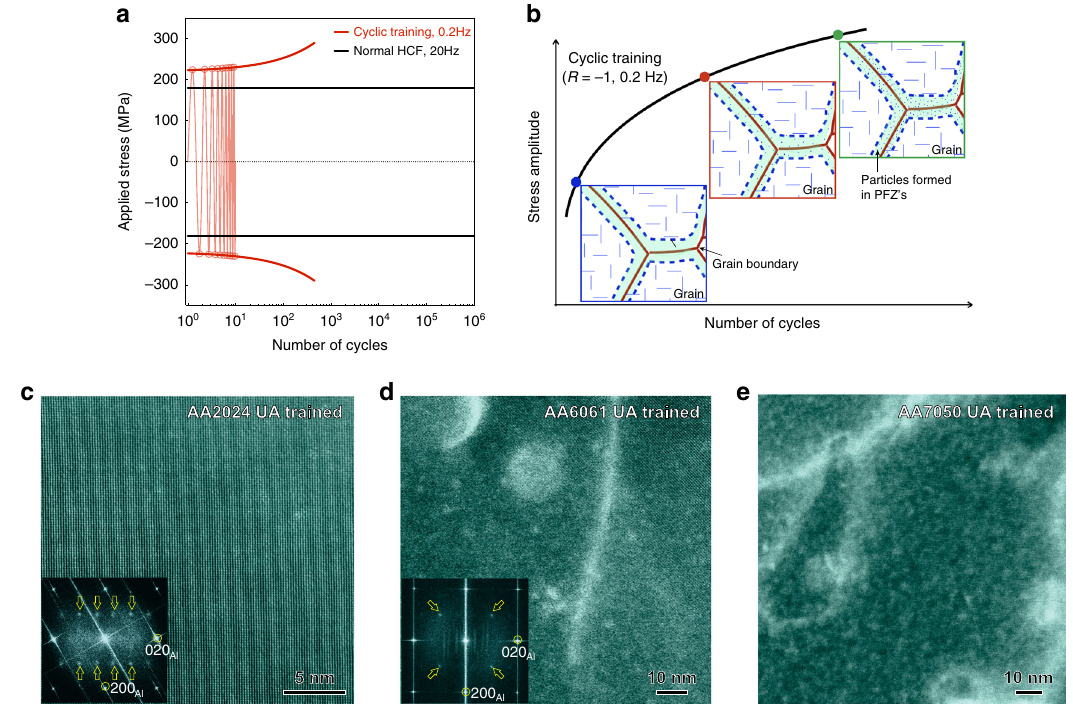
Fig. 5 Cyclic training and microstructure evolution during cyclic training for the under aged (UA) alloys. a Schematic illustration of the fully reversed ( R = − 1) cyclic training at 0.2 Hz. b Schematic illustration of the precipitation in PFZ ’ s as the training cycle number increases. c – e LAADF-STEM images showing nanoprecipitates formed in PFZ ’ s of AA2024 trained for 450 cycles ( c ), AA6061 trained for 700 cycles ( d ), and AA7050 trained for 450 cycles ( e ). Inset FFT patterns in c , d show diffraction from nanoprecipitates (indicated by yellow color hollow arrows). The electron beam direction was parallel to <100> Al in c , d and parallel to <110> Al in e